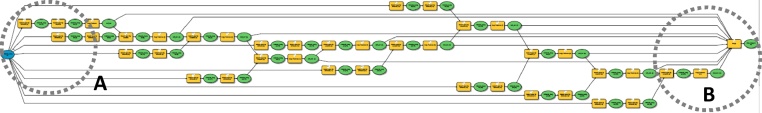
The full workflow sequences of the Stage 2 as modeled in ModelBuilder.